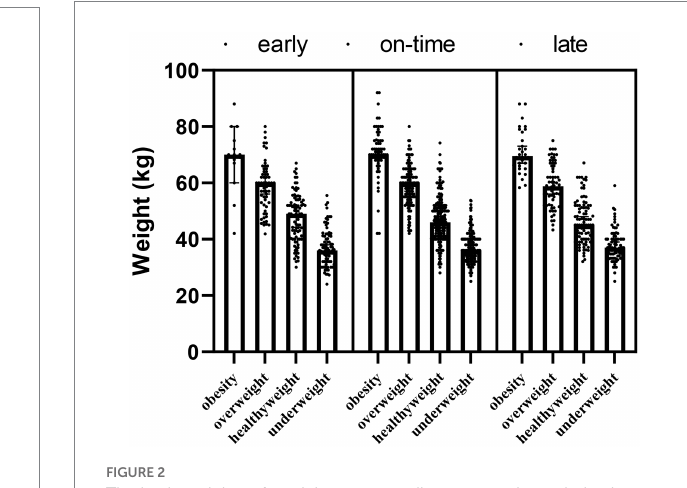
FIGURE 1 Ages of the participants by maturity and obesity groups.